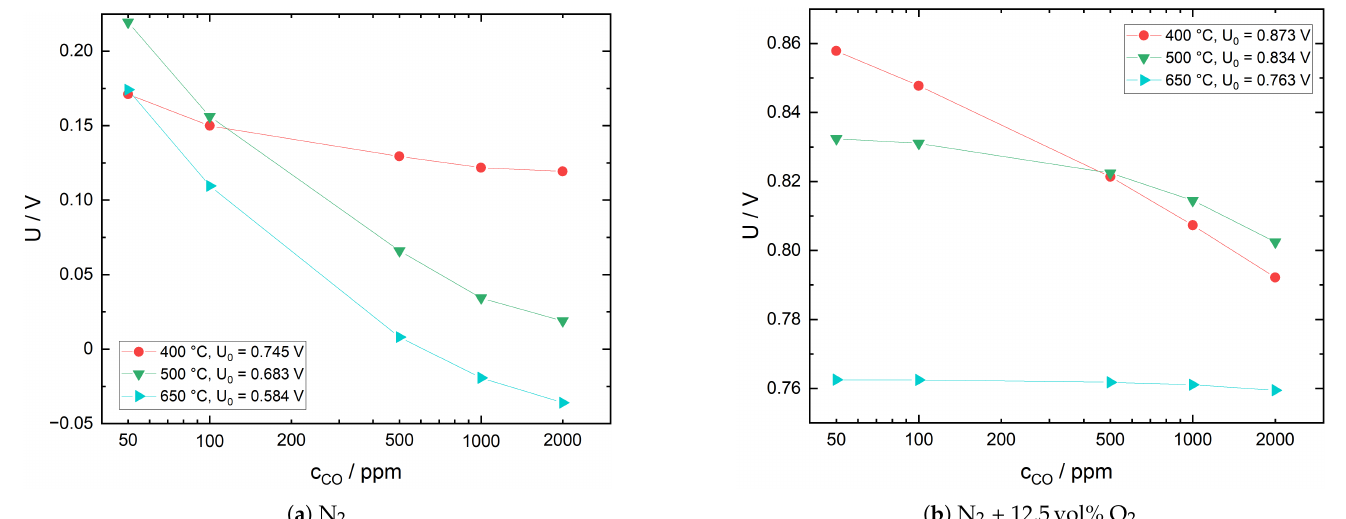
Figure 4. Sensor with Pt cermet sensing electrode, response behavior to CO in two different sample gas mixtures. Baseline sensor voltages in the absence of CO are given by U 0